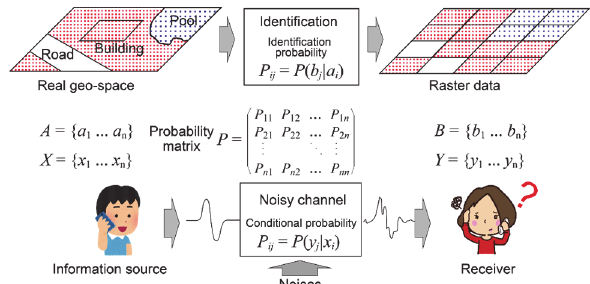
Figure 2 . Noisy channel model in the raster data creation process.